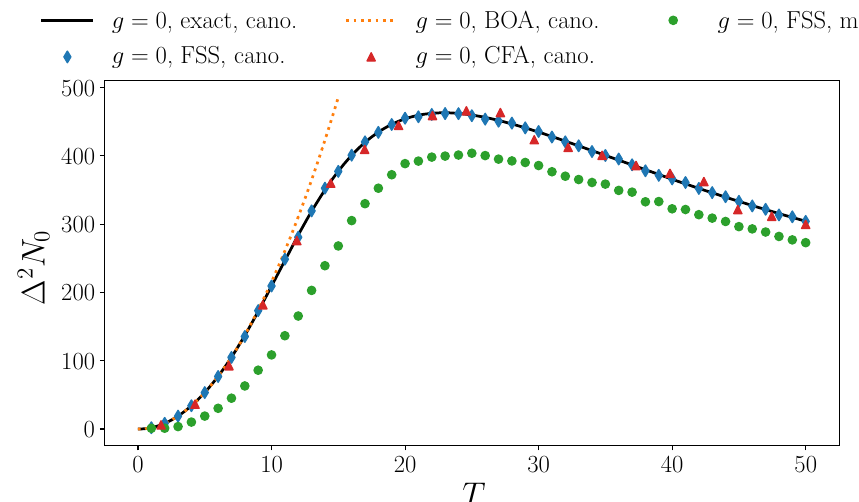
Figure 2: Fluctuations of a non-interacting Bose gas containing N = 100 atoms in a 1D ring trap. The variance of N as a function of temperature in 1D in canonical 0 ensemble is obtained from several different approaches: FSS method, classical field approximation, Bogoliubov approach (BOA) and an exact method (see text). In ad- dition a microcanonical calculation using the FSS method is presented, showing the clear reduction of the expected fluctuations in this ensemble. The temperature T is L 2 ) . given in units 2 π 2 ħ h 2 / ( mk B